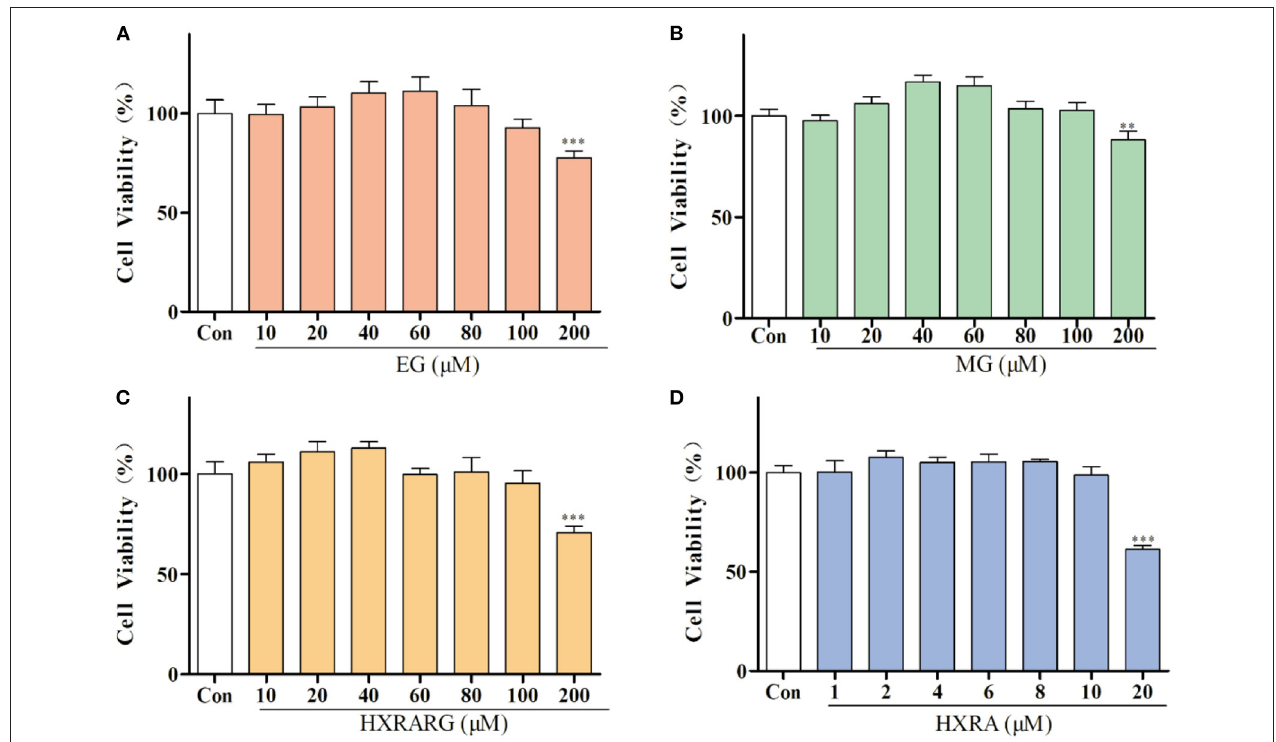
FIGURE 2 | Effects of EG (A) , MG (B) , HXRARG (C) , and HXRA (D) on the viability of RAW264.7 cells. Data are expressed as the means ± SD. Compared with the control, ** P < 0.01, *** P <